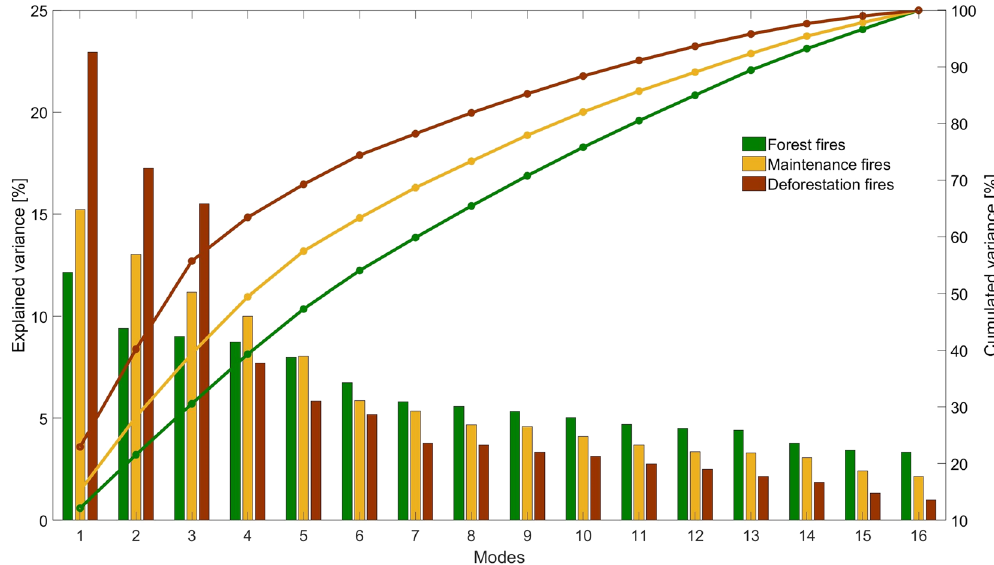
Figure 5. The variances explained by the different modes for each type of fire activity: forest (green), maintenance (orange) and deforestation fires (brown) for the 2003–2019 period.